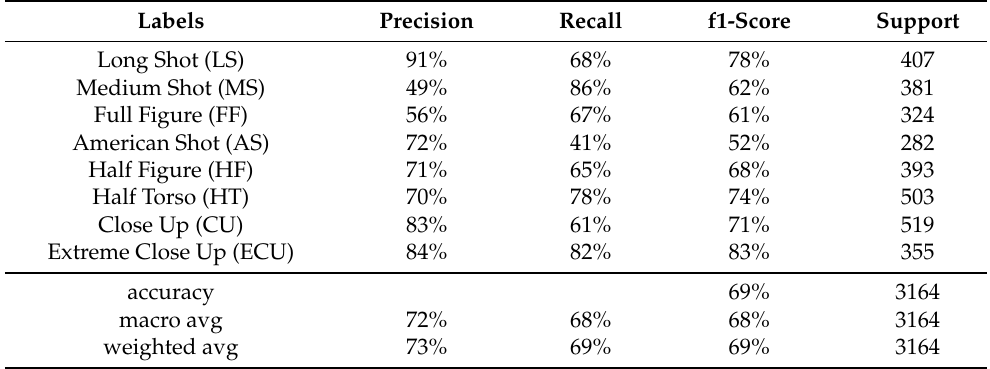
Table 15. Precision recall and f1-score of a ResNet50 trained on the OD plus the flip on the y-axis